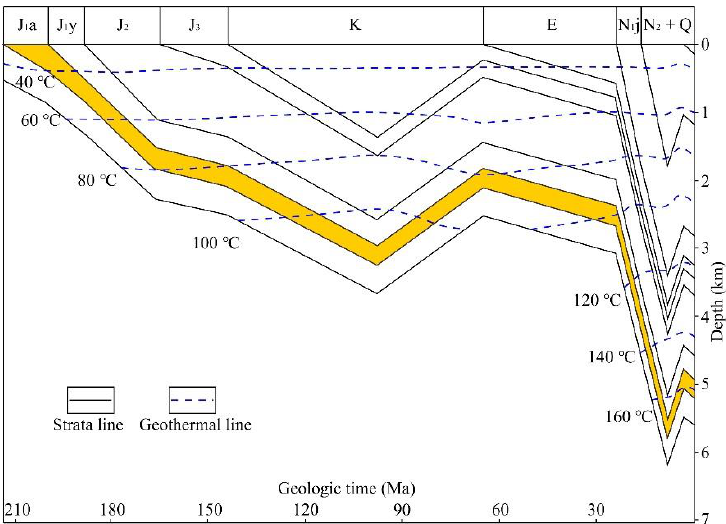
Figure 9. Burial, thermal history, and geothermal line of well DB102.